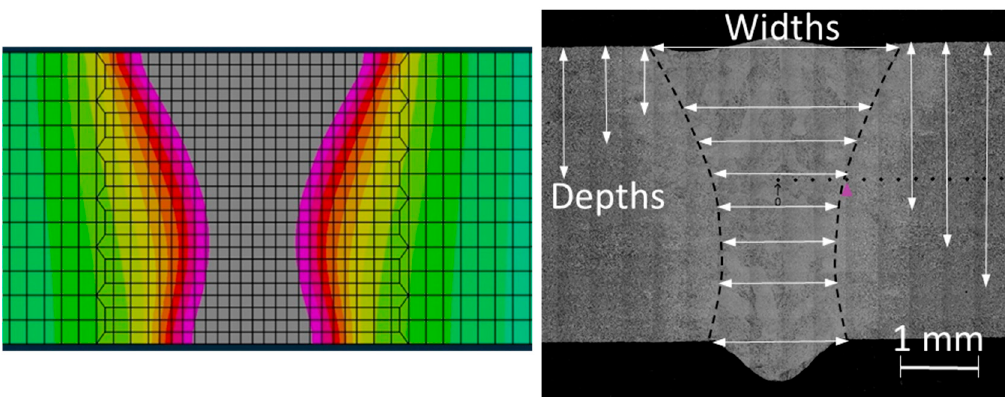
Figure 11 . FE-predicted weld pool shape for weld c using the Cartesian coordinate (width vs. depth) methodology.